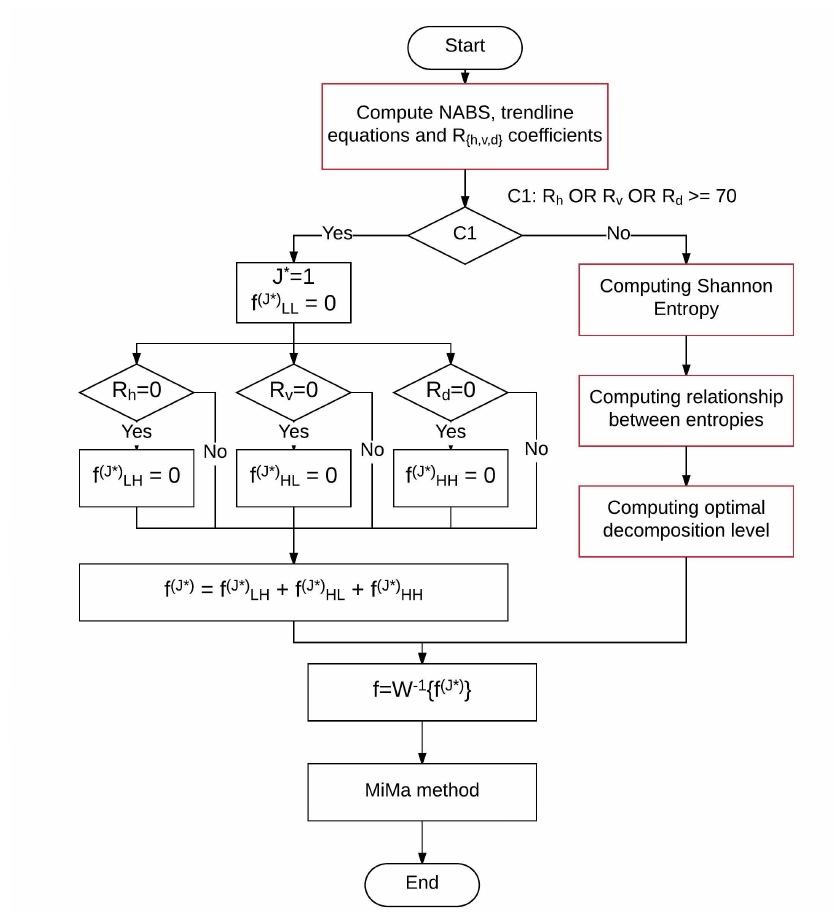
Figure 9. Flowchart to implement the entropy-based automatic selection of the wavelet decomposition level (EADL) method. See Equation (5) for R h , R v , and R d